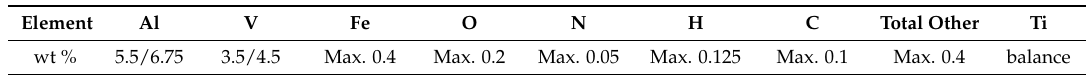
Table 1. Chemical composition of Ti-6Al-4V